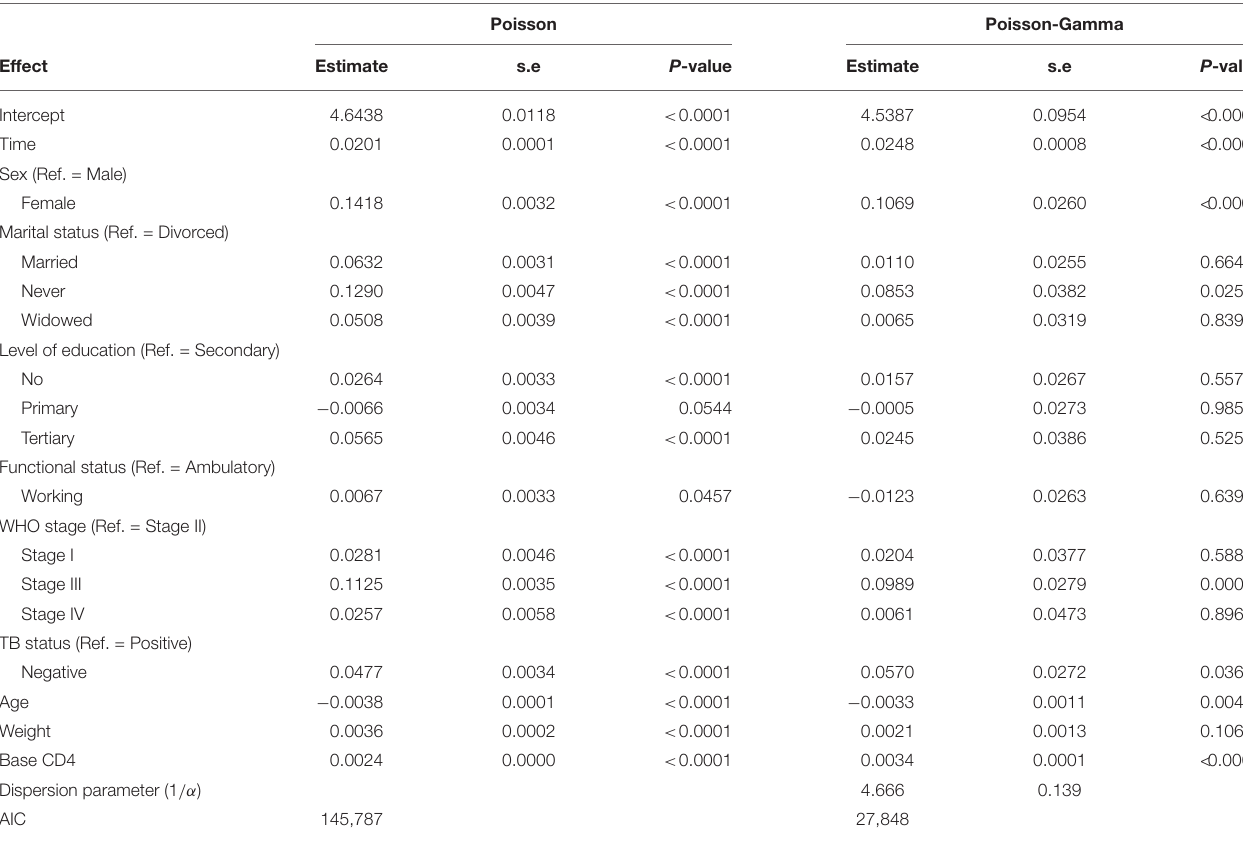
TABLE 4 | Poisson and Poisson-Gamma